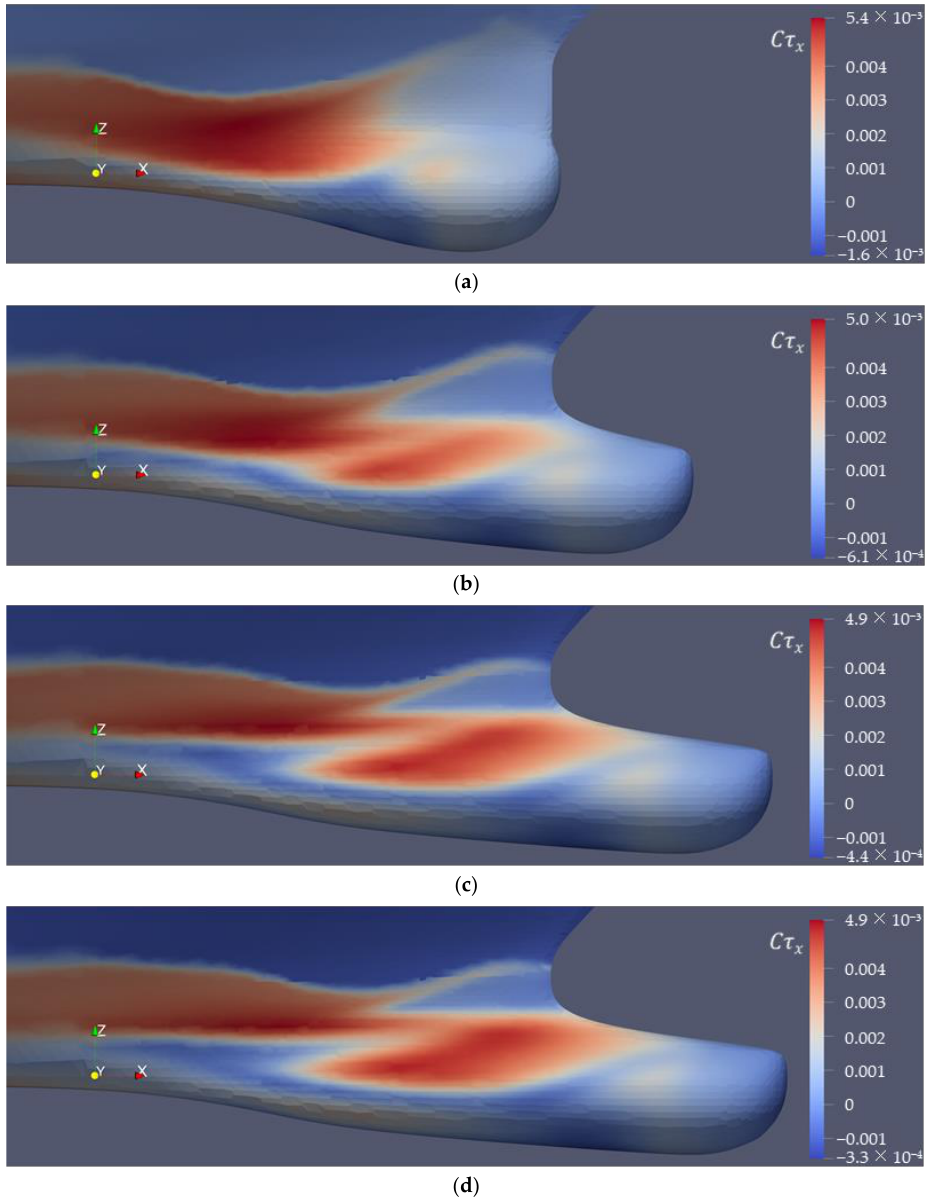
Figure 14. Distribution of wall shear stress ( 𝐶𝜏 𝑥 ) on ship ’s bow and sonar dome surface: ( a ) F0; ( b ) F0.14; ( c ) F0.225; ( d ) F0.24.